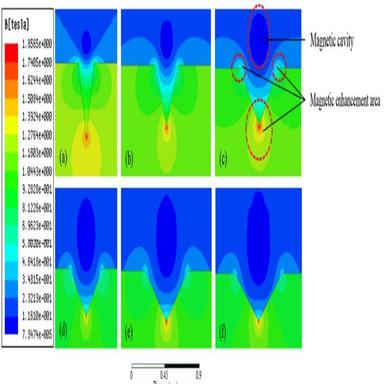
Simulation results of different triangular defect widths for HMM; (a) Triangular defect width of 0.1 mm; (b) Defect width of 0.2 mm; (c) Defect width of 0.3 mm; (d) Defect width of 0.4 mm; (e) Defect width of 0.5 mm; (f) Defect width of 0.6 mm.